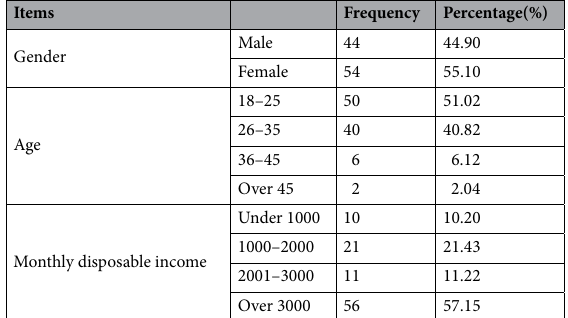
Table 1. The demographic information of Study